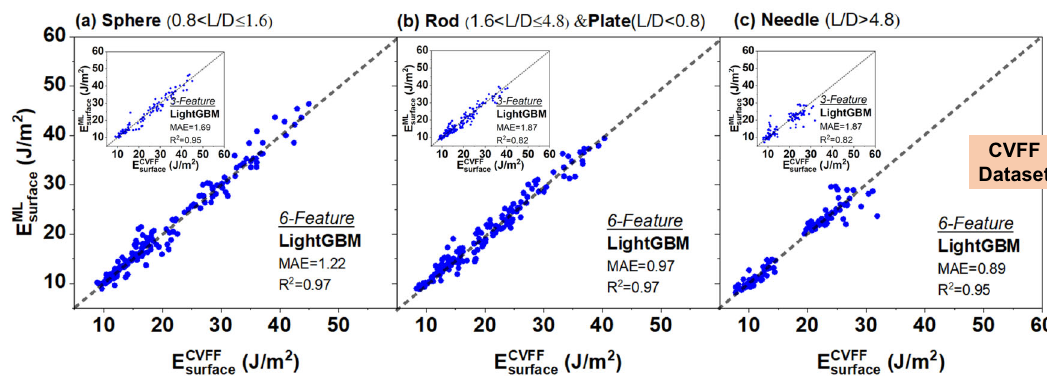
Fig. 5 Surface energy prediction on CVFF dataset with LightGBM. a Sphere HANPs. b Rod and plate HANPs. c Needle